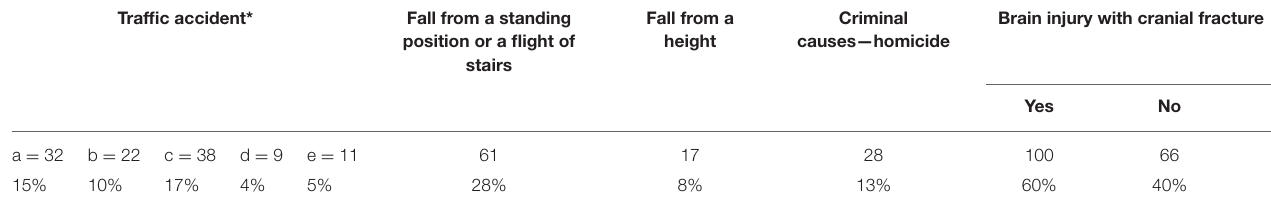
TABLE 1 | Mechanism of injury. Traffic accident* Fall from a standing